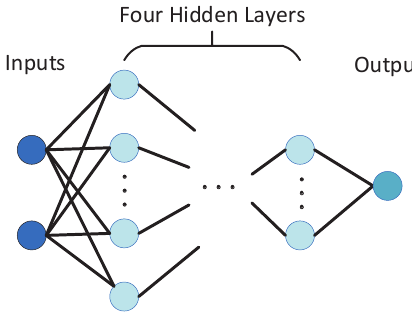
Figure 2. Multilayer Perceptron (MLP) model structure with four hidden